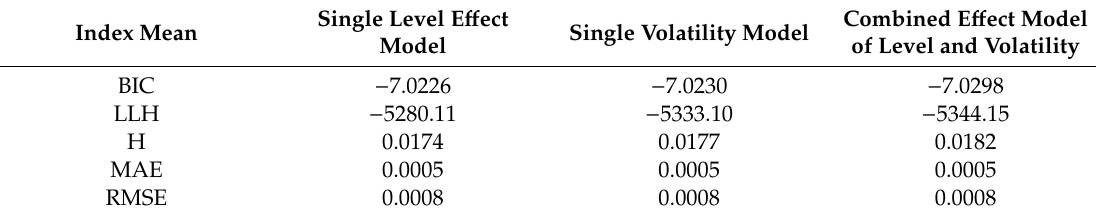
Table 10. Comparison of the mean value between associative e ff ect model and the single-factor level and fluctuation e ff ect model in the high-frequency